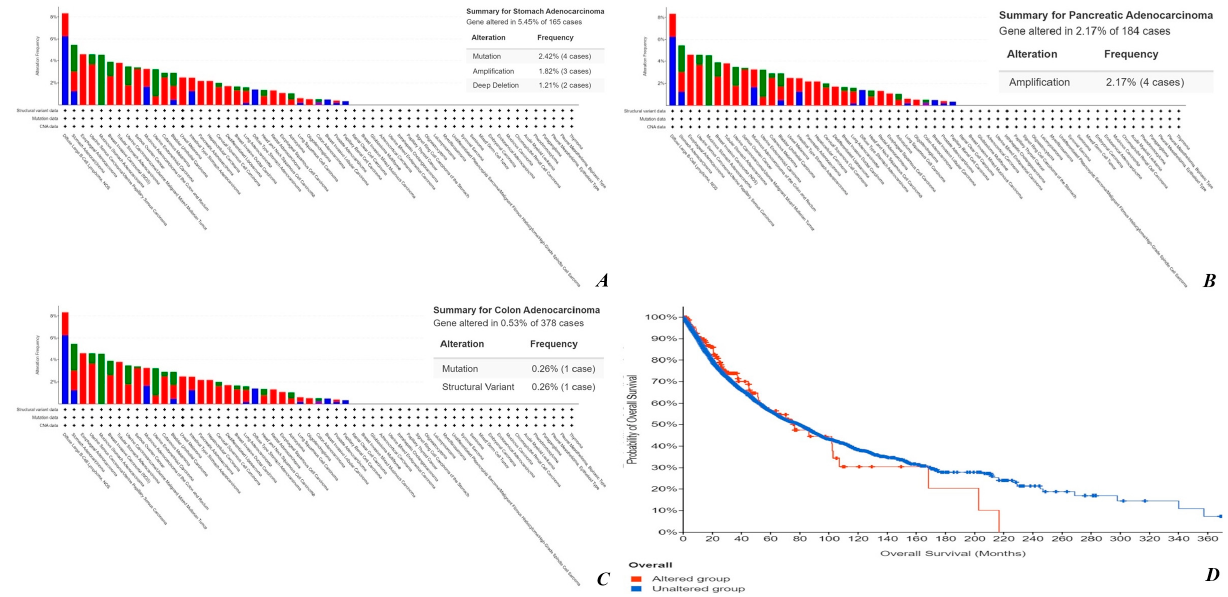
Figure 7. CLIC1 alteration from TCGA database in gastric adenocarcinoma ( A ), pancreatic adenocarci- noma ( B ) and colorectal adenocarcinoma ( C ). CLIC1 expression and overall survival interrelation ( D